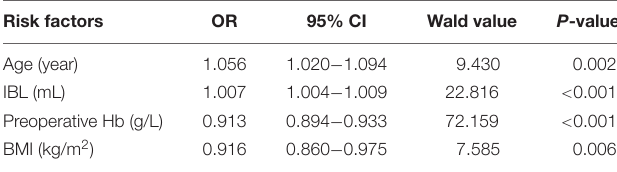
TABLE 2 | Multivariate stepwise logistic regression analysis of ABT after HA in elderly patients with